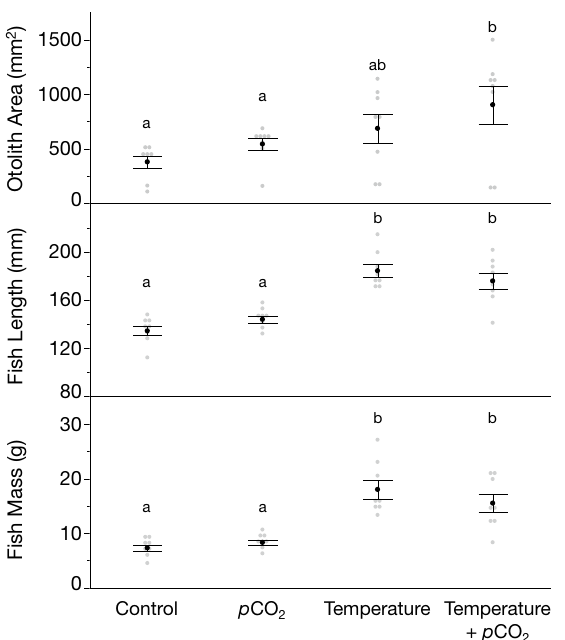
Figure 2. Mean (± s.e.m.) otolith area (mm 2 ), fish length (mm), and fish mass (g) within each experimental treatment (i.e., control [15 °C, 1000 μatm p CO 2 ], p CO 2 [15 °C, 2500 μatm p CO 2 ], temperature [22 °C, 1000 μatm p CO 2 ], temperature + p CO 2 [22 °C, 2500 μatm p CO 2 ]). Grey points represent measurements for each individual (n = 8/treatment) and are jittered on the x-axis for visualization. Treatments not sharing the same letter are significantly different (ANOVA, p <